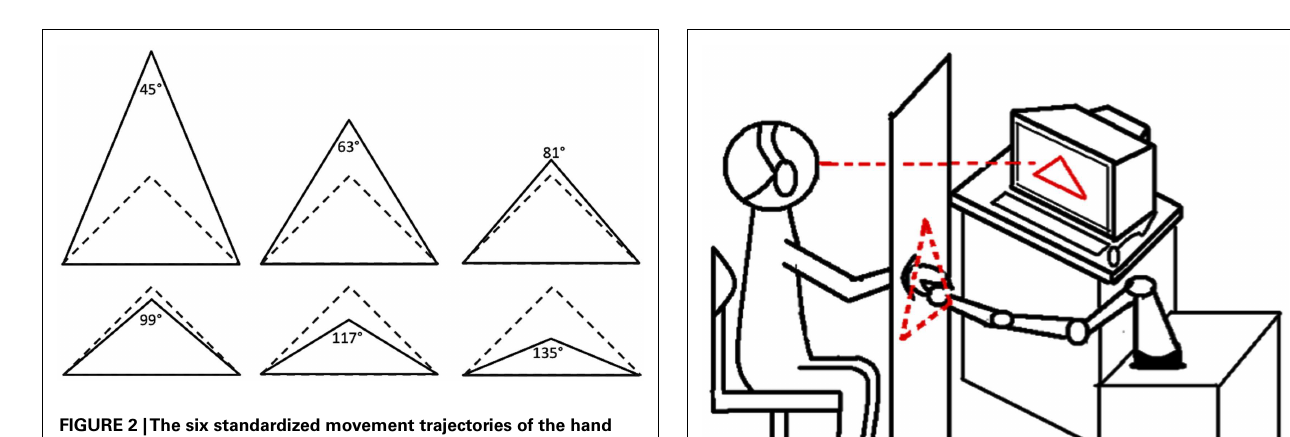
FIGURE 2 |The six standardized movement trajectories of the hand (solid lines). For visual feedback an equal-sided right-angled triangle (with dashed lines) was constantly displayed.